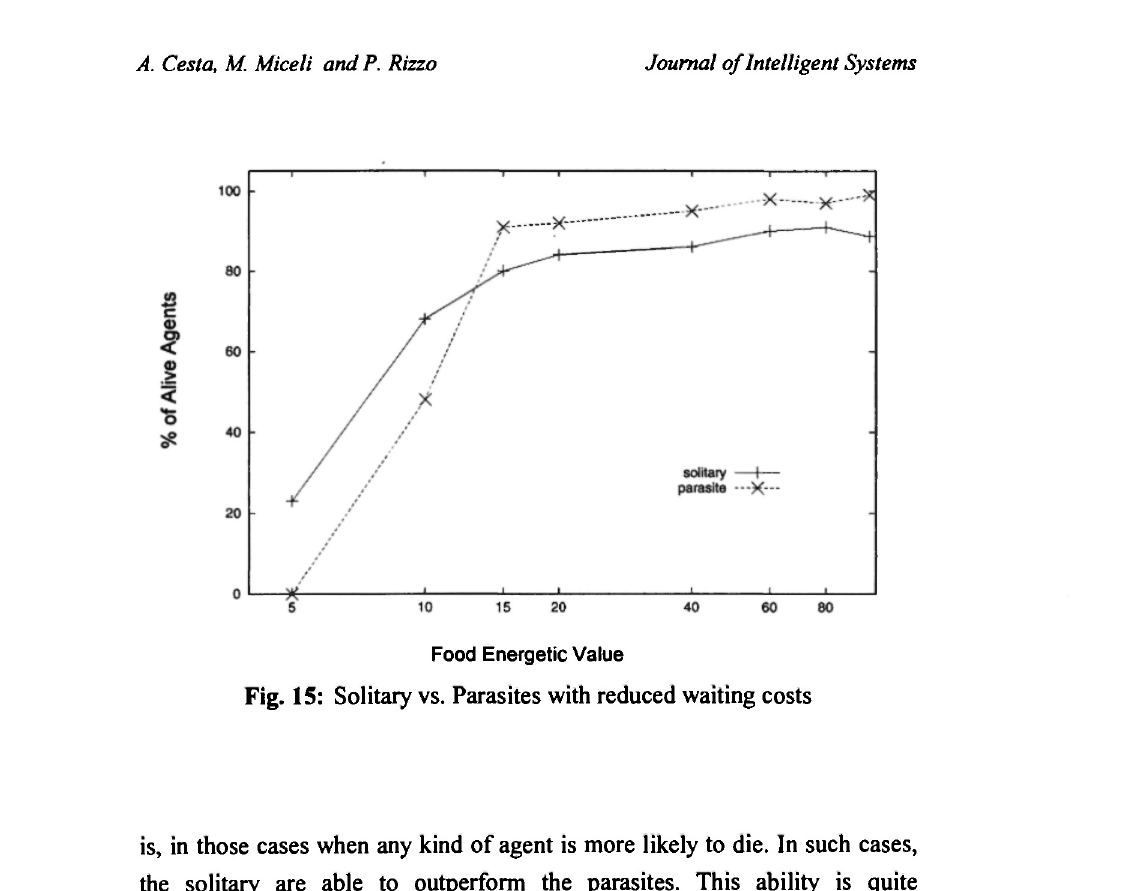
Fig. 15: Solitary vs. Parasites with reduced waiting